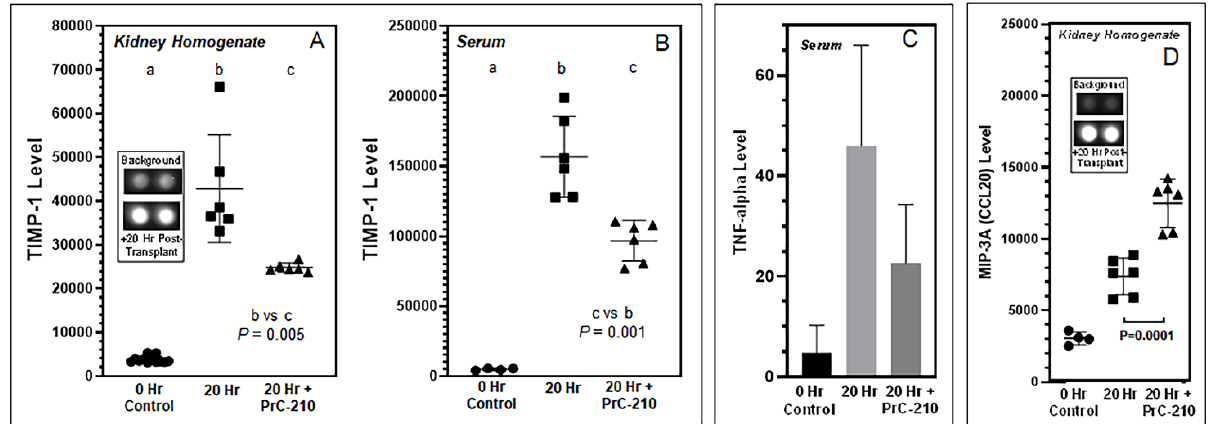
Figure 6. Effect of PrC-210 administration on serum and kidney homogenate cytokine levels 20 h after transplant of the BN kidney into a LEW rat. ( A , B ) TIMP-1, ( C ) TNF-alpha and ( D ) MIP-3A/CCL20 levels were determined by ELISA analysis. Serum collection and transplanted BN kidney harvest and homogenization were done as described in Methods. p values are indicated. a,b,c designations are used to enable statistical comparisons between groups.